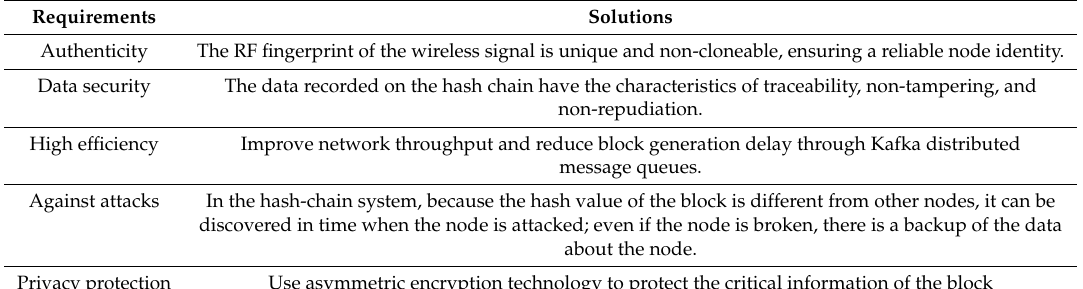
Table 1. Security requirements and corresponding solutions in the space–air–ground integrated